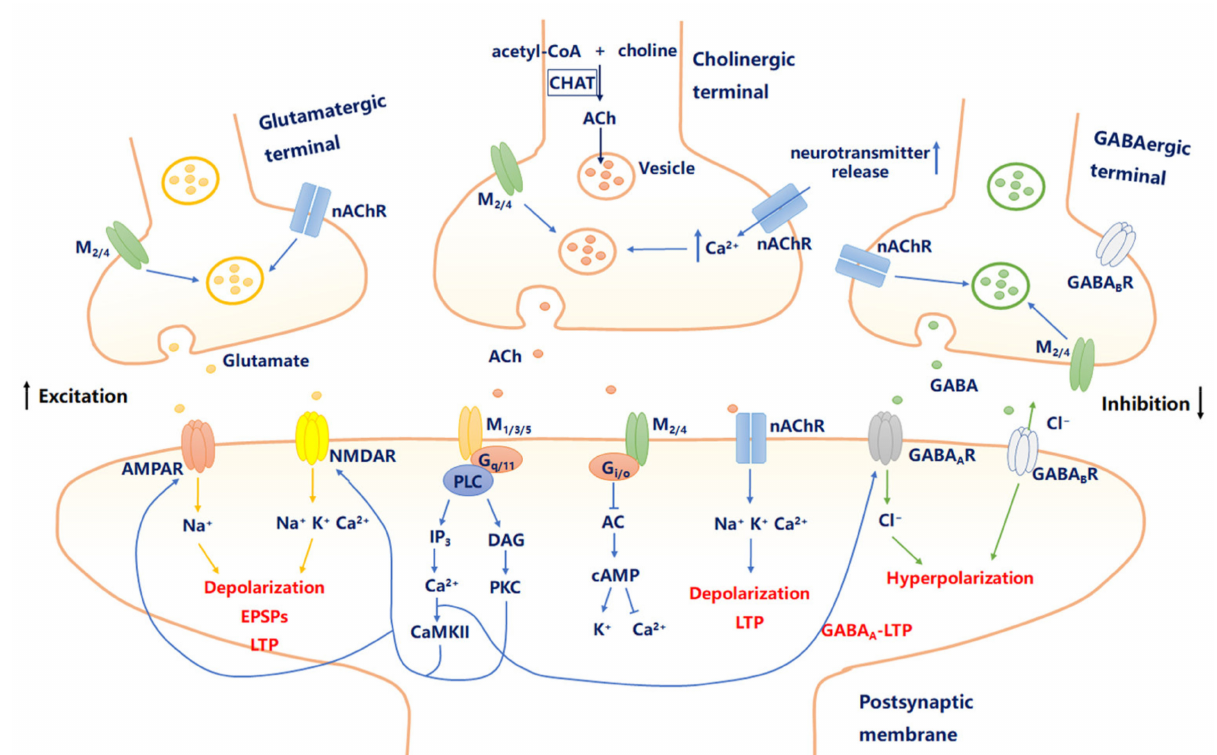
Figure 1. Cholinergic signaling modulates “excitation–inhibition” balance in the brain. Presynaptic or postsynaptic muscarinic acetylcholine receptors (mAChRs) and nicotinic acetylcholine receptors (nAChRs) influence synaptic plasticity by increasing intracellular Ca 2+ release, induction of long-term potentiation (LTP), and leading to a depolarization. Additionally, the excitation of presynaptic nAChRs increases the release of many neurotransmitters including dopamine, norepinephrine, γ -aminobutyric acid (GABA), and glutamate (Glu) in a Ca 2+ -dependent